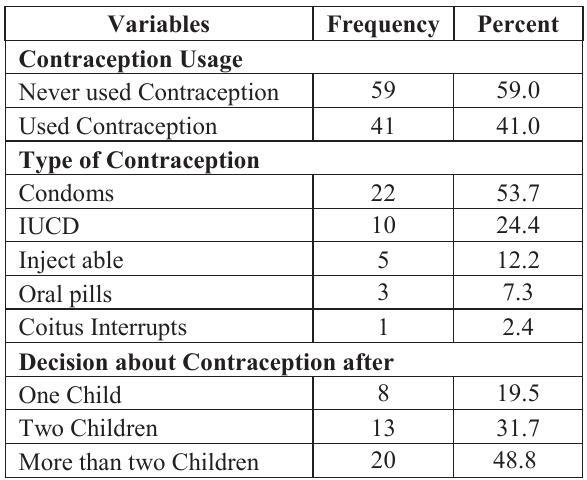
Table-1: Contraception Practices among females (n=100)